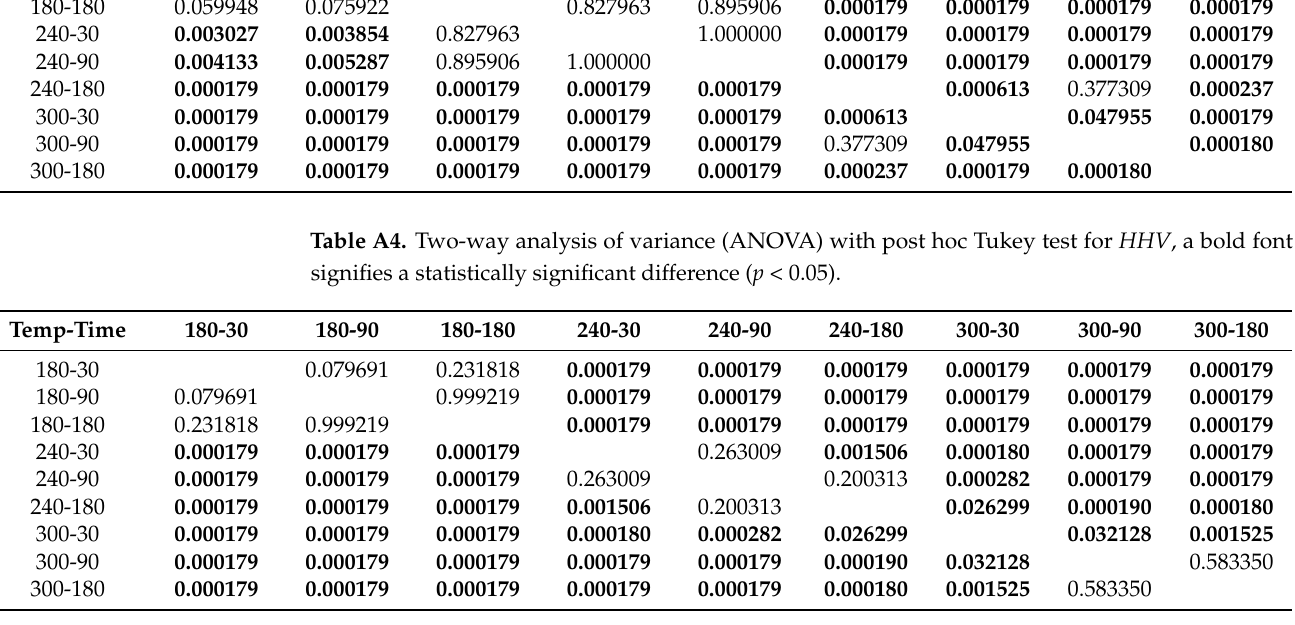
Table A5. Two-way analysis of variance (ANOVA) with post hoc Tukey test for EDr , a bold font signifies a statistically significant difference ( p < 0.05).